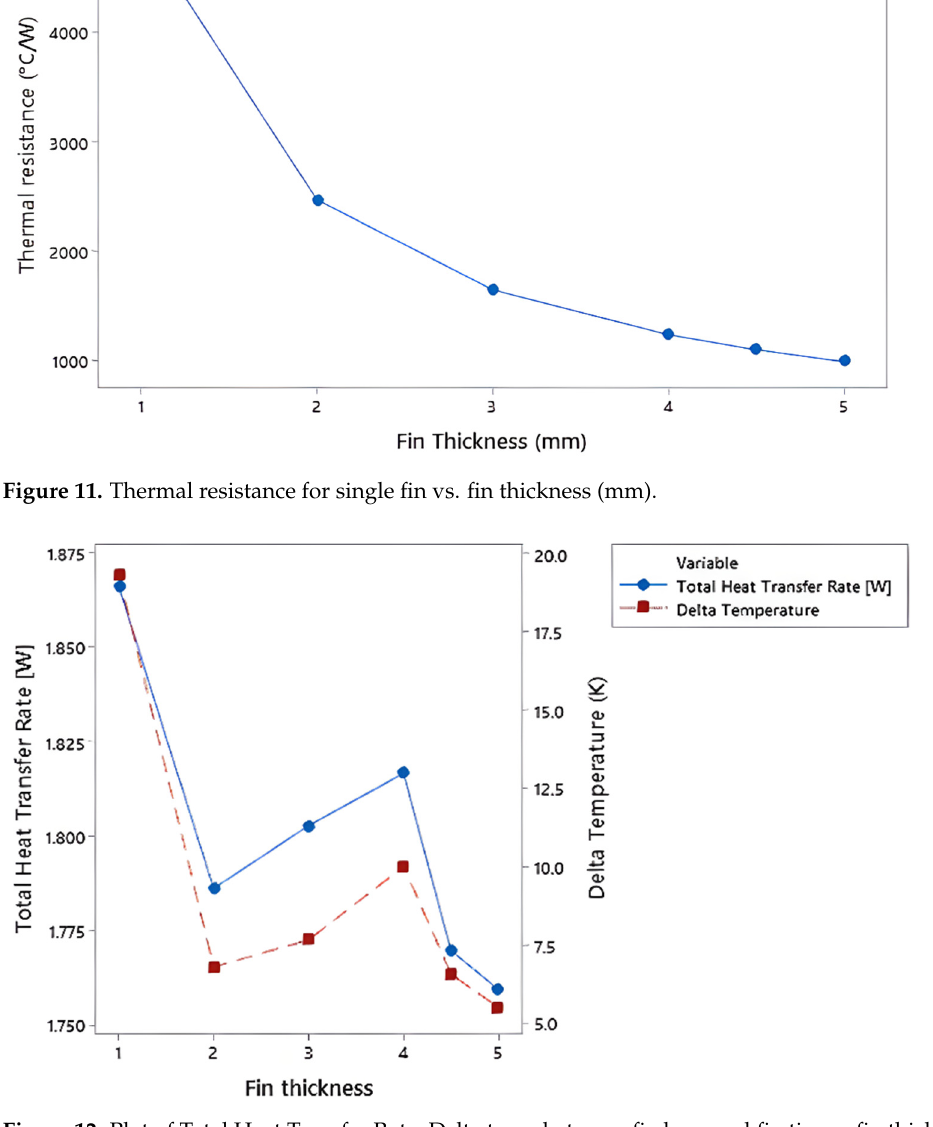
Figure 12. Plot of Total Heat Transfer Rate, Delta temp between fin base and fin tip vs fin thick- ness .